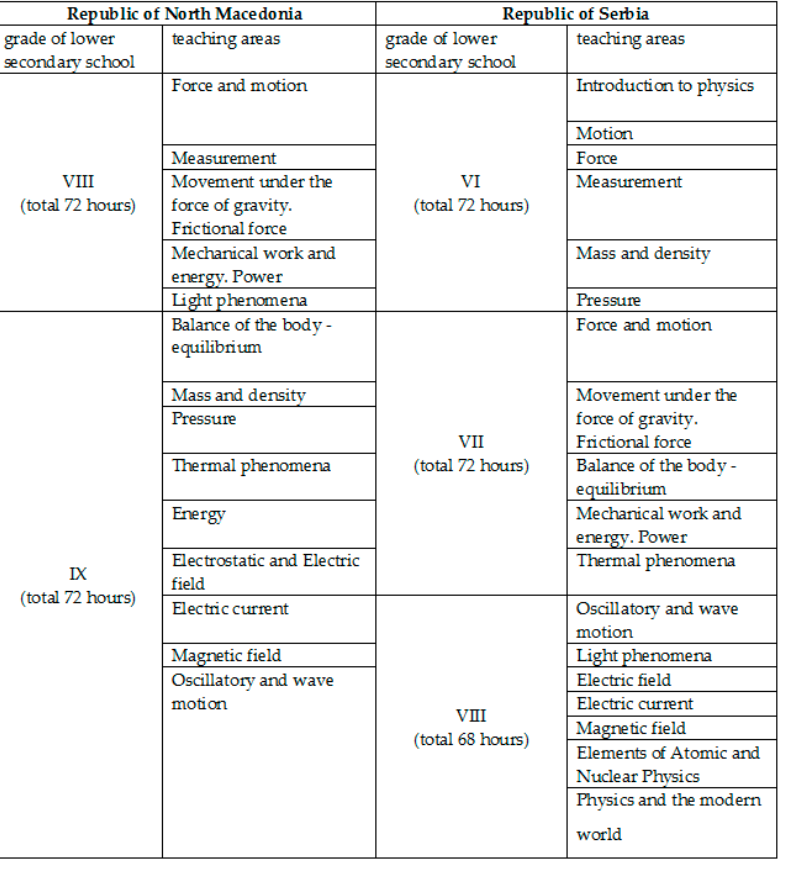
Figure A1. Comparative overview of the studied teaching areas in physics for lower secondary school.